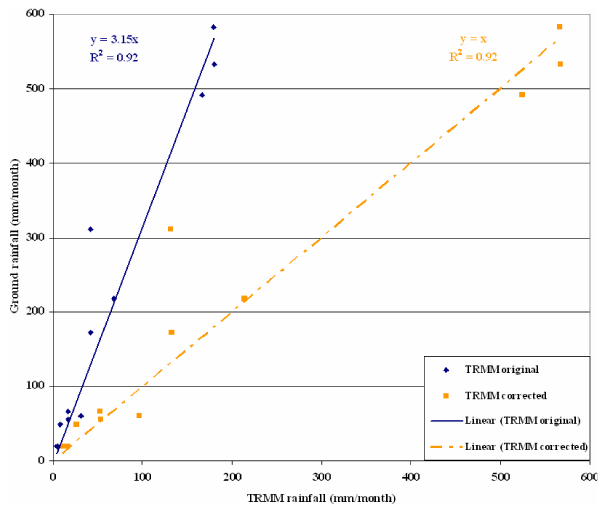
Fig. 3. Bias correction at a monthly scale. Puerto ila